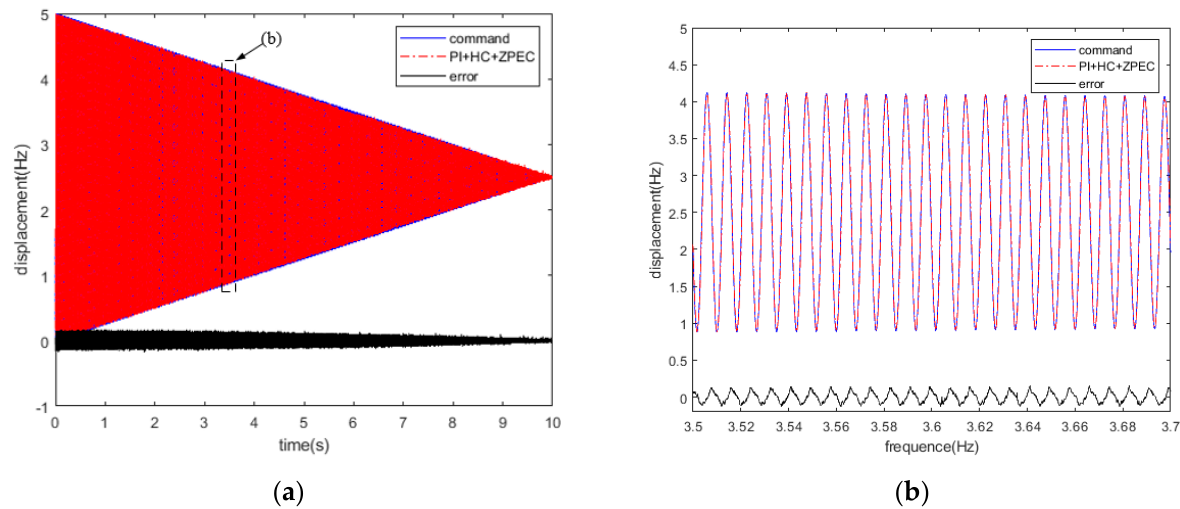
Figure 15. Tracking error of the five-leaved signal; ( a ) five-leaved signal; ( b ) tracking error.